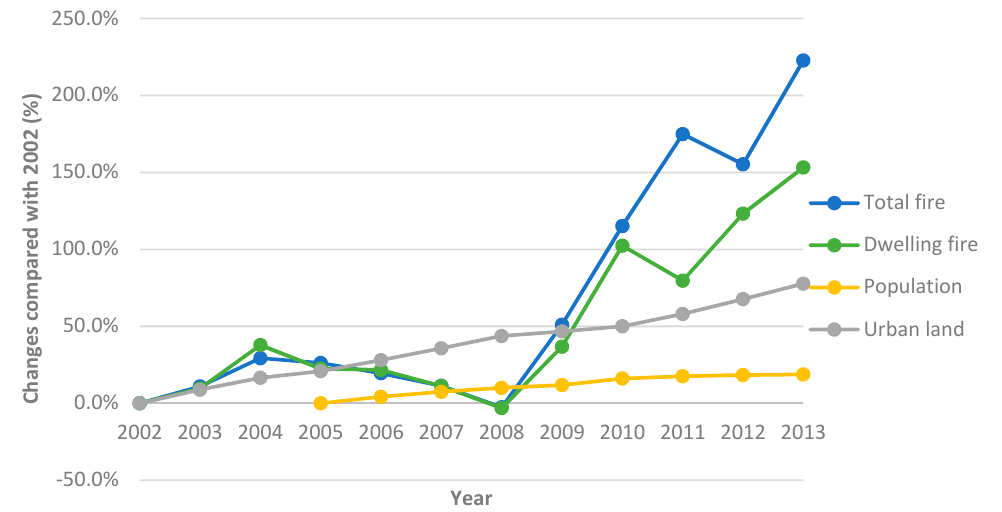
Figure 10. Temporal variations of urban population, urban land and urban fires (2002–2013).